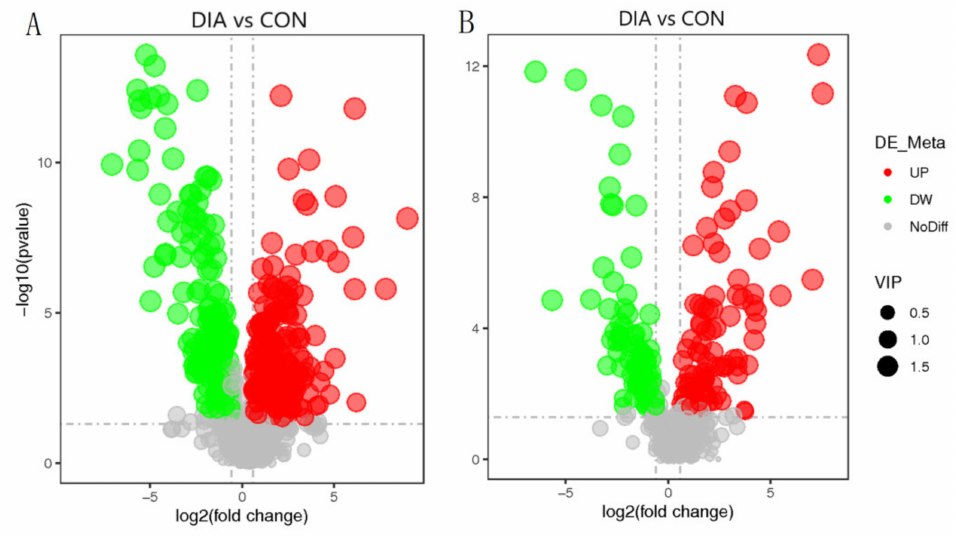
Figure 9. Volcano map of DMs in colon tissue of DIA and CON. Positive DMs ( A ), negative DMs ( B